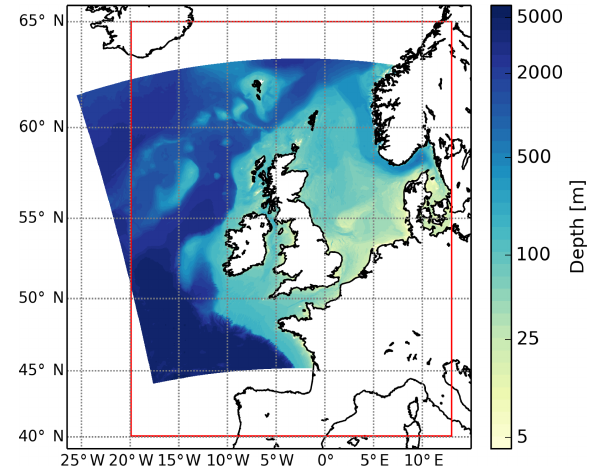
Figure 1. Map illustrating the location and bathymetry of the model domain (indicated by the shaded region). Shading shows bathymetry from EMODnet (in metres; note logarithmic scale). Red line illustrates the extent of the current operational domain, AMM7 (7km